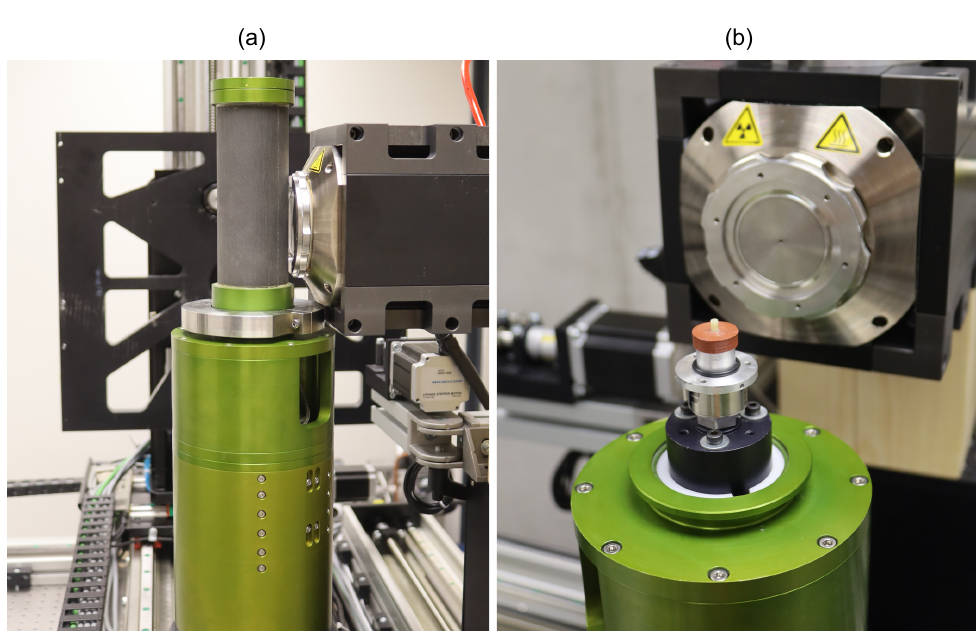
Figure 1. The experimental setup with the in situ loading device mounted in the X-ray scanner: ( a ) the scanning position for maximal magnification and ( b ) a detailed view on the open device with the sample placed for testing.